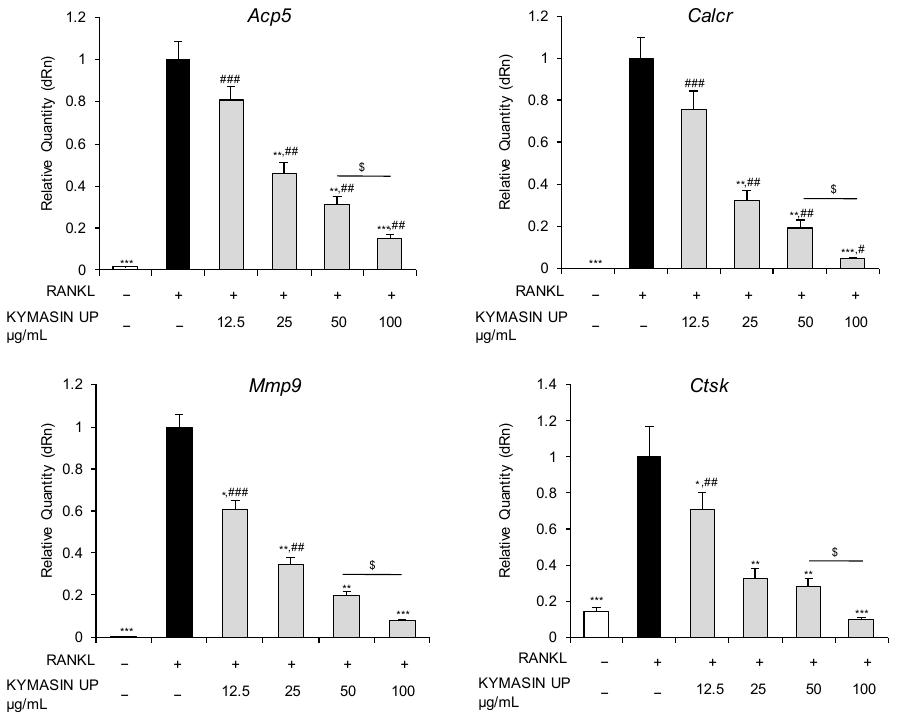
Figure 1. RAW 264.7 cells were treated for 5 days with RANKL (receptor activator of nuclear factor- kappa B ligand) in the absence (black bars) or presence of KYMASIN UP (12.5–100 µ g/mL) (grey bars). The untreated control was also shown (white bars). Real-time PCR analysis of the osteoclast (OC) markers, Acp5 (acid phosphatase 5, tartrate resistant), Calcr (calcitonin receptor), Mmp9 (matrix metallopeptidase 9), and Ctsk (cathepsin K) was performed. Gene expressions were normalized to Gapdh . Six independent experiments were performed. Statistical analysis was conducted using the two-tailed t -test. * p < 0.05, ** p < 0.01, and *** p < 0.001, significantly different from RANKL. # p < 0.05, ## p < 0.01, and ### p < 0.001, significantly different from untreated control. $ p < 0.05, significantly different.